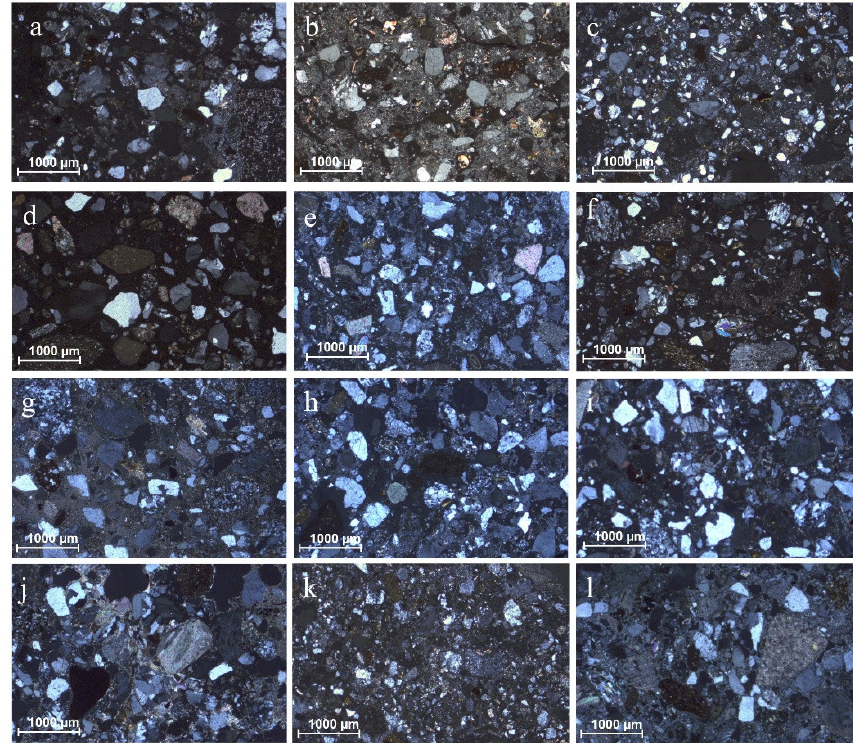
Figure 5. Thin section microphotographs (XPL) of some selected samples: C2-X ( a ), C2b-Y ( b ), C3-X ( c ), C5-Z ( d ), C5-W ( e ), C6-Y ( f ), C7-X ( g ), C7-Y ( h ), C10-X ( i ), C10-Y ( j ), C11-X ( k ), and C13-X ( l ).